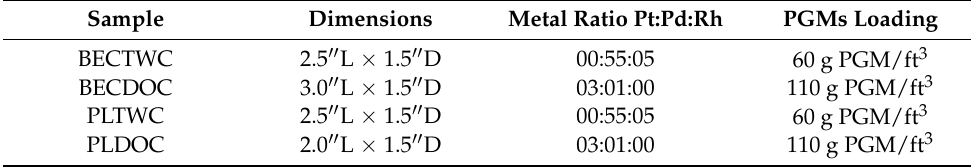
Table 1. Detailed characteristics of prepared catalytic monoliths (monolithic carrots).